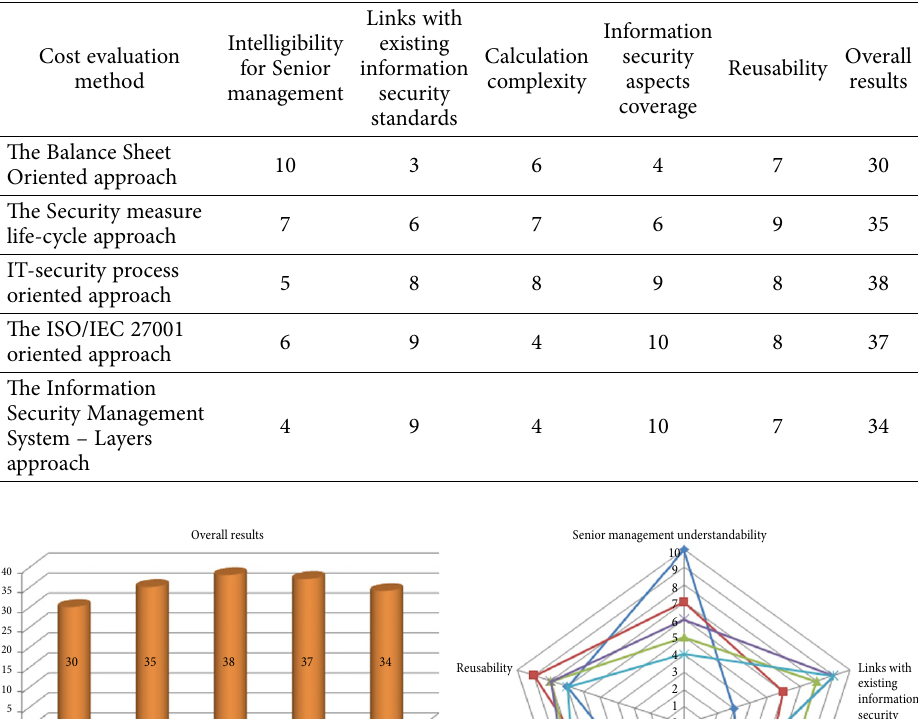
Links with existing information